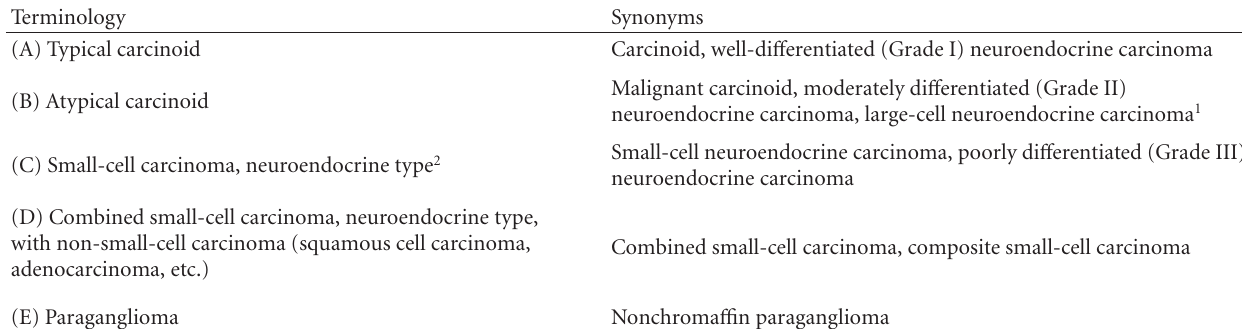
Table 1: Classification of neuroendocrine tumors of the larynx by WHO, 2003.